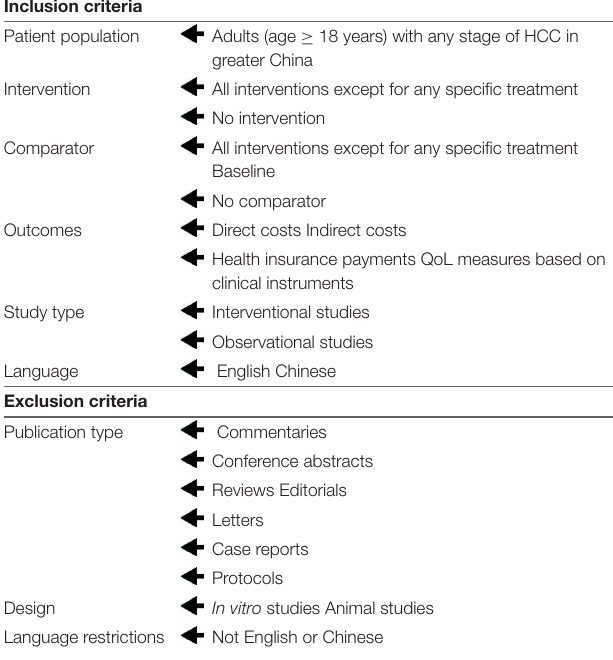
TABLE 1 | Eligibility criteria. Inclusion